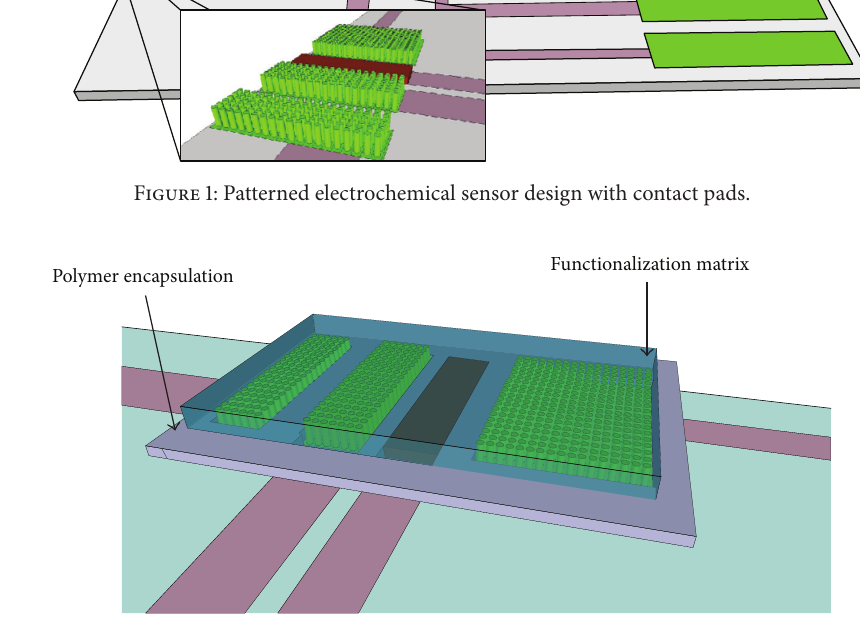
Figure 2: Nanopatterned electrodes coated with a functionalizing (immobilization) matrix.